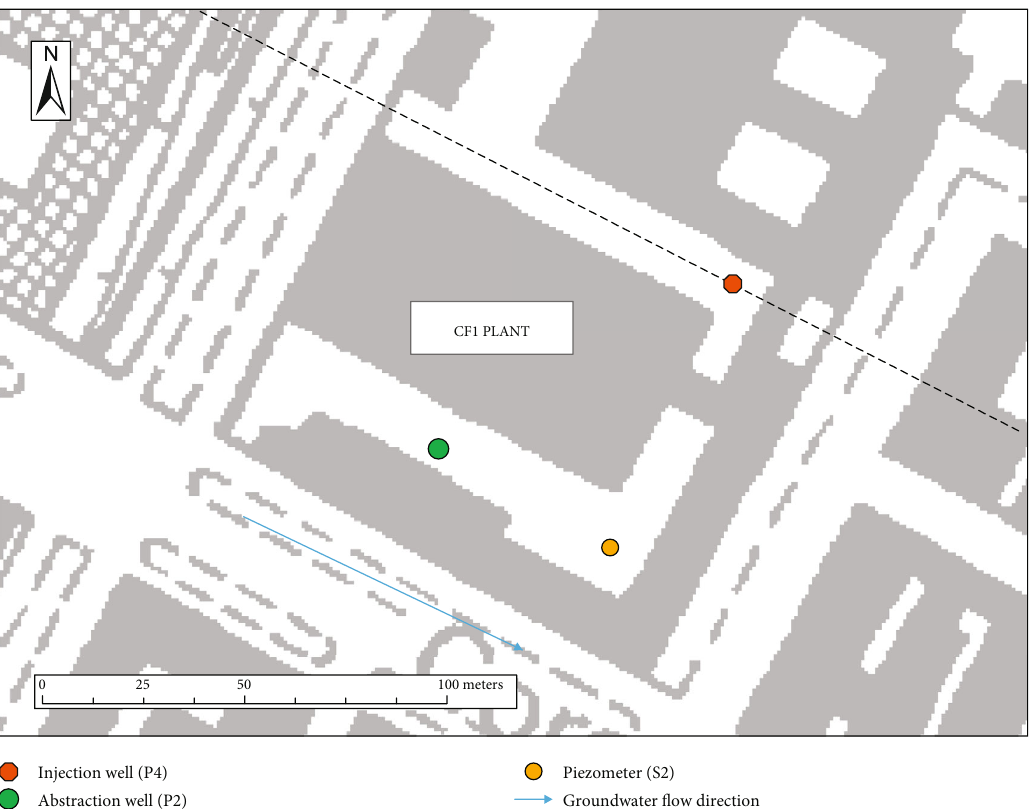
Figure 1: Politecnico CF1 plant GWHP system overview. P2: abstraction well, P4: reinjection well, S2: control piezometer. Dotted line indicates the direction of the cross-section line reported in Figure 3 [12].